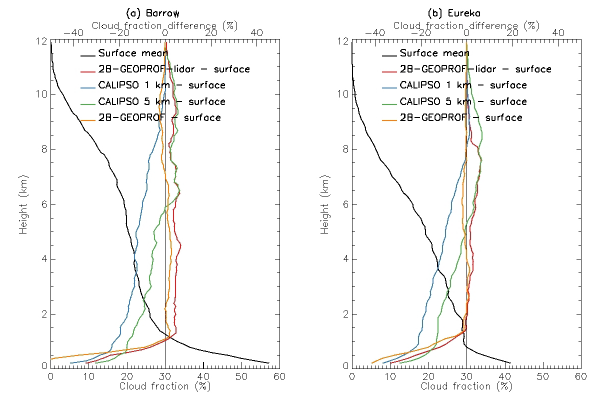
Figure 4. Mean vertical distributions of cloud fraction from surface observations and the difference of 2B-GEOPROF-lidar, CALIPSO 1km, and CALIPSO 5km, and 2B-GEOPROF minus surface ob- servations at (a) Barrow and (b) Eureka for